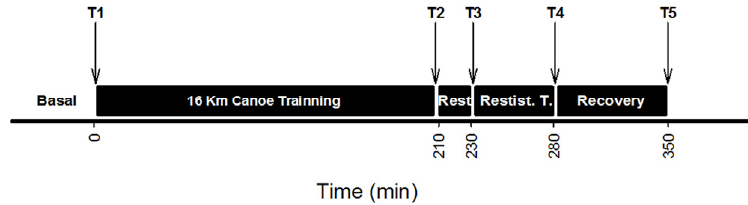
Figure 1. Experimental trial. Blood samples of the athletes were collected at the time points indicted in the Figure and as described in materials and methods.